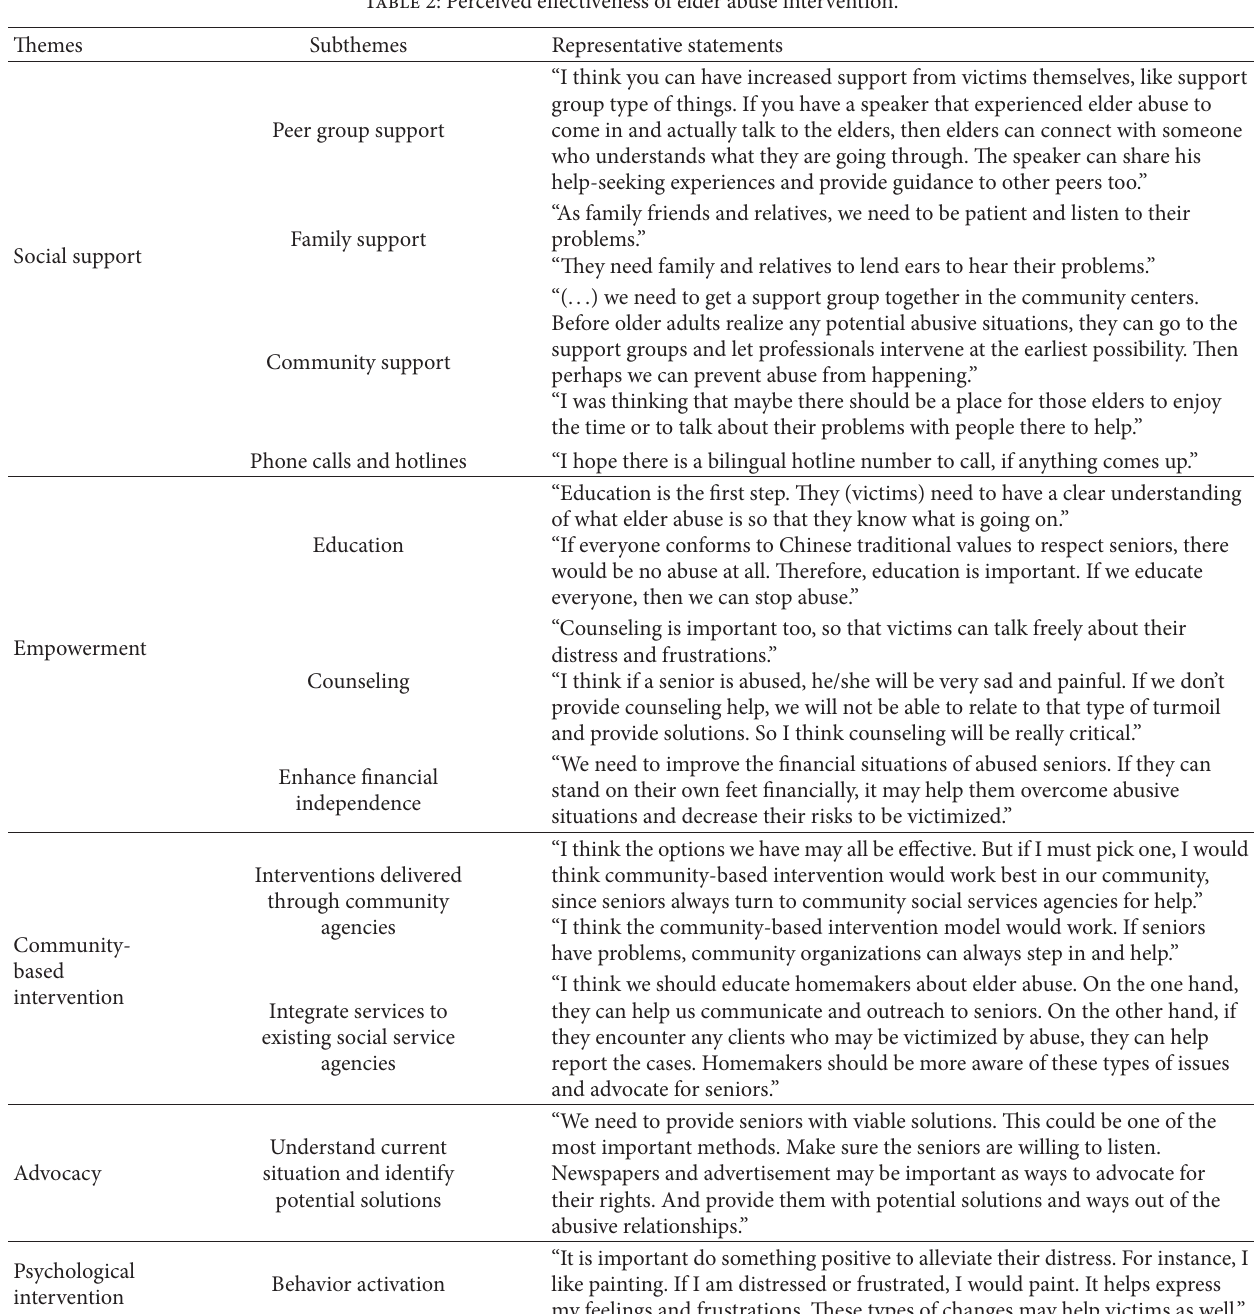
Table 2: Perceived effectiveness of elder abuse